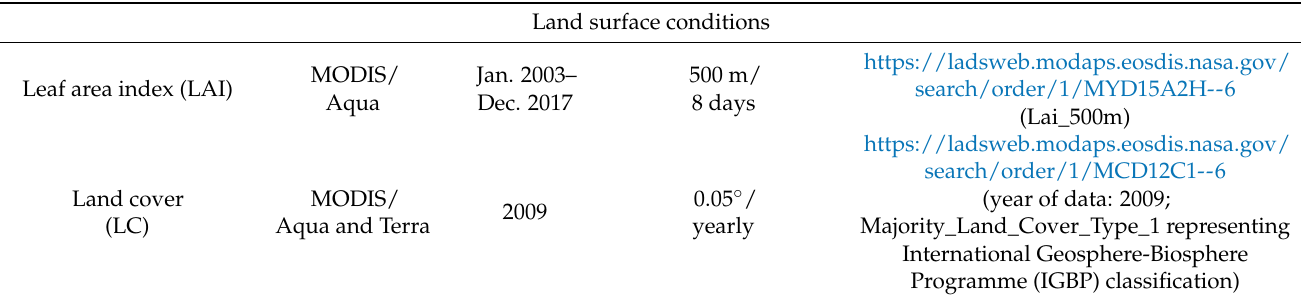
Table 1. Cont. Land surface